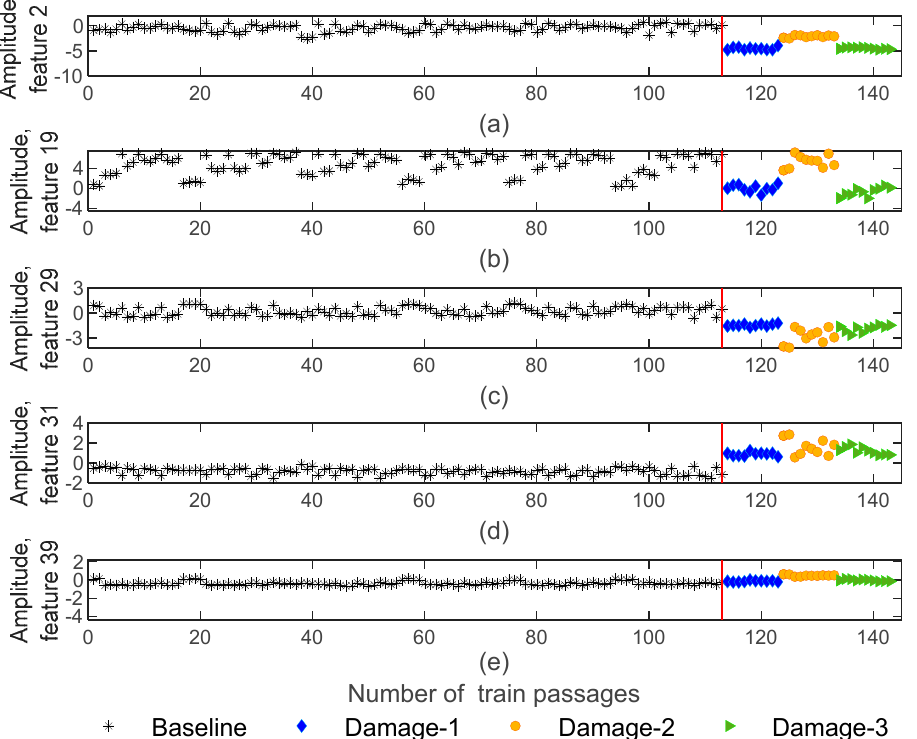
Figure 8. AR—feature extraction for all 143 baseline and damaged scenarios for accelerometer 3: ( a ) amplitude for feature 2, ( b ) amplitude for feature 19, ( c ) amplitude for feature 29, ( d ) amplitude for feature 31, ( e ) amplitude for feature 39.